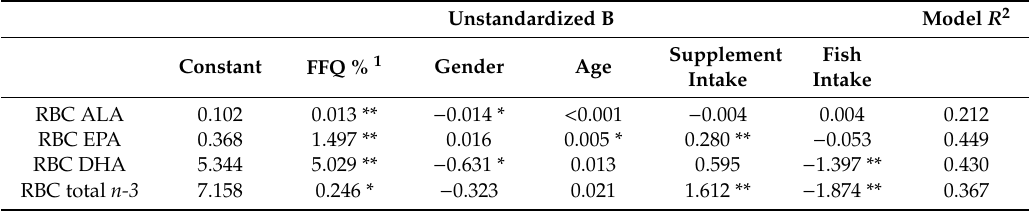
Table 4. Multiple linear regression models with each individual RBC n-3 PUFA as the dependent and the respective calculated FFQ PUFA, gender, age, supplement intake (yes / no), and fish intake (yes / no) as independent variables ( n =